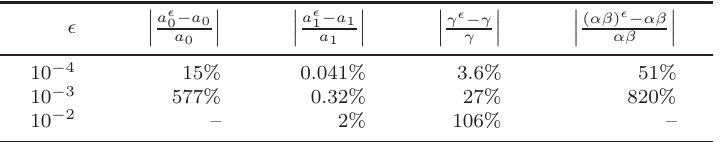
= 2 . 1 , a = 1 , γ = 10 − 4 , αβ = 10 − 4 (weak 0 1